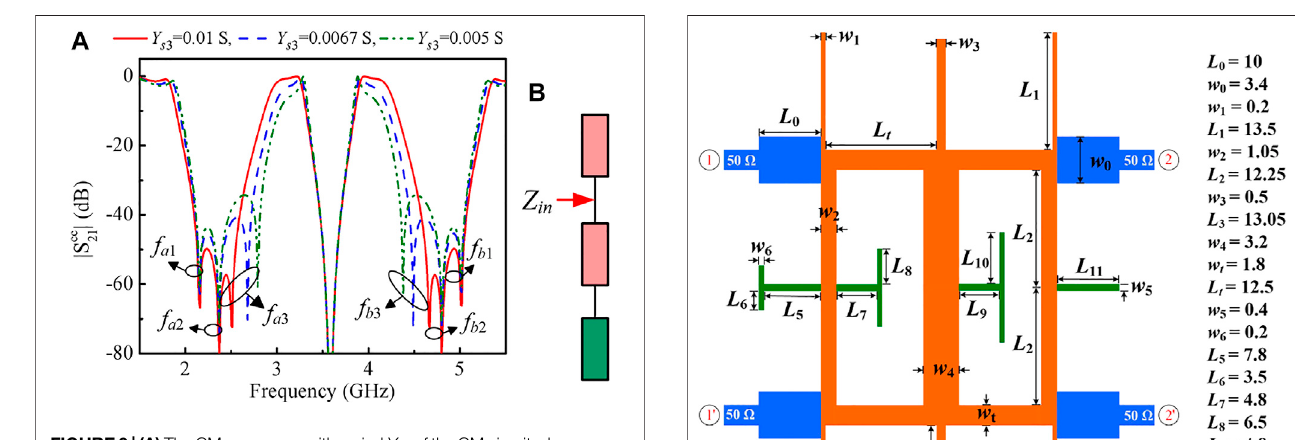
FIGURE9|(A) TheCMresponseswithvaried Y s 3 oftheCMcircuitwhen Y s 1 (cid:1) 0.01 S and Ys2 (cid:1) 0.0067 S (B) The TLM of TZ generation.